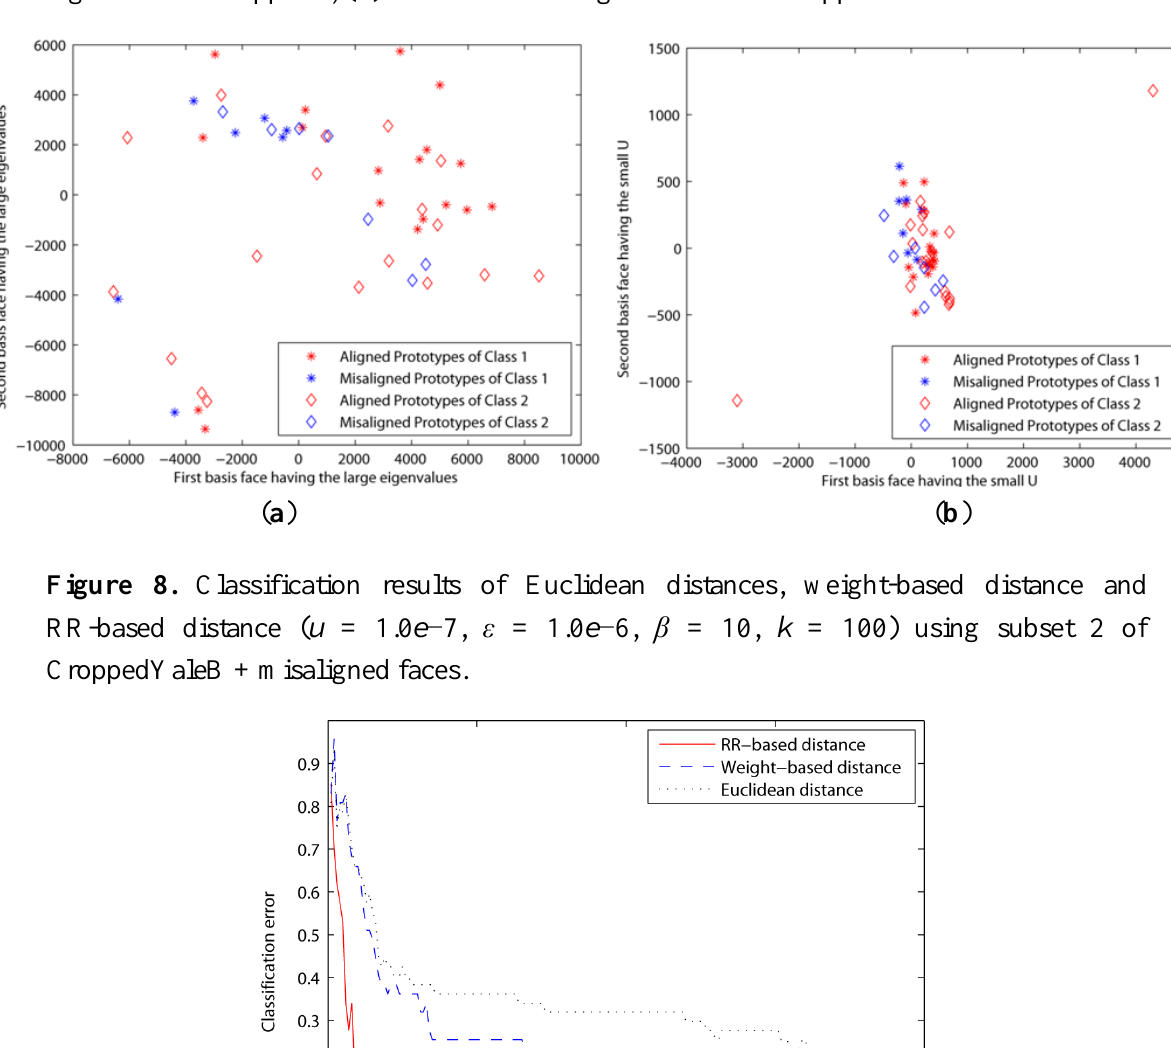
Figure 7. Prototypes projected by two basis faces ( u = 1.0 e −7, ε = 1.0 e −6, β = 10, k = 100, H = 10) using CroppedYaleB + misaligned faces: ( a ) Basis faces having the large eigenvalues are applied; ( b ) Basis faces having the small U are applied.